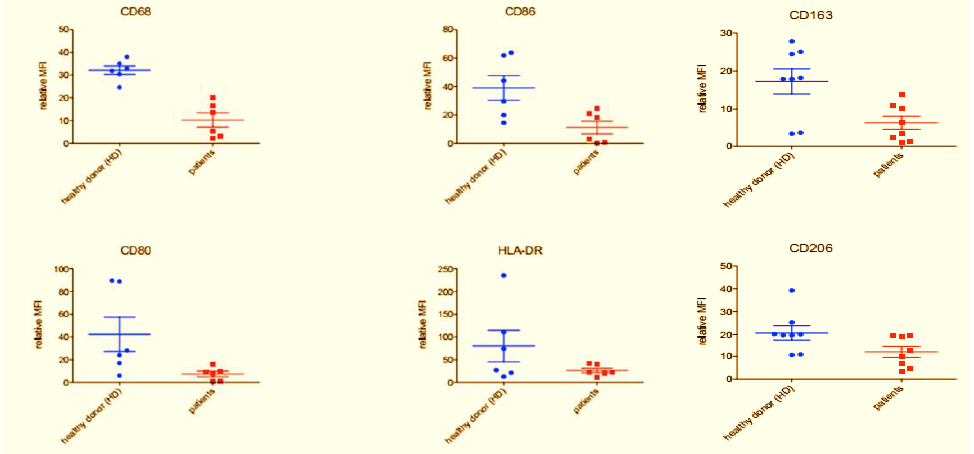
Figure 5. Histogram overlays obtained by using the FlowLogic software. Representative data obtained from healthy donor-derived macrophage culture (blue histograms) and patient-derived macrophage culture (red histogram). Histogram overlays were obtained by using the FlowLogic software.